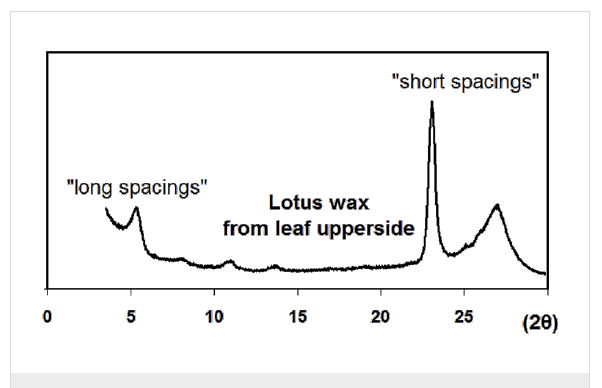
Figure 12: X-ray diffraction diagram of upperside lotus wax. The ‘long spacing’ peaks indicate a layer structure which is common in aliphatic waxes. The broad ‘short spacing’ peak at 2 θ = 27° indicates a strong disorder in the lateral package of the